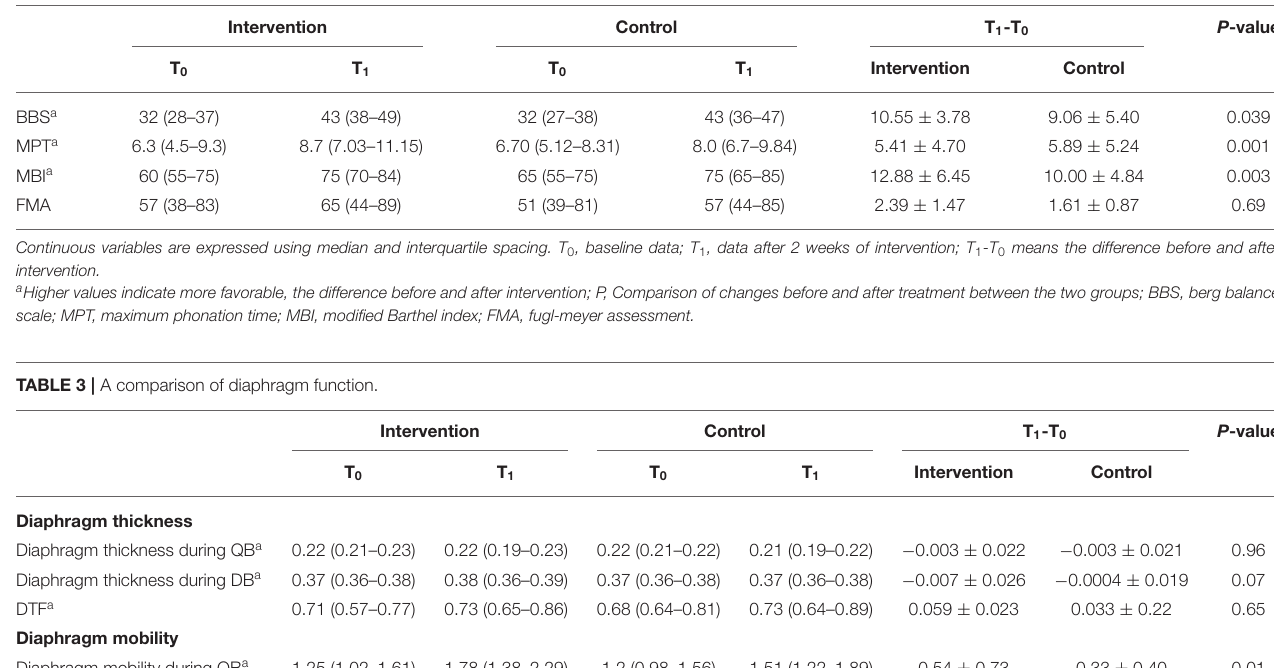
TABLE 2 | A comparison of BBS, MPT, MBI, and FMA.